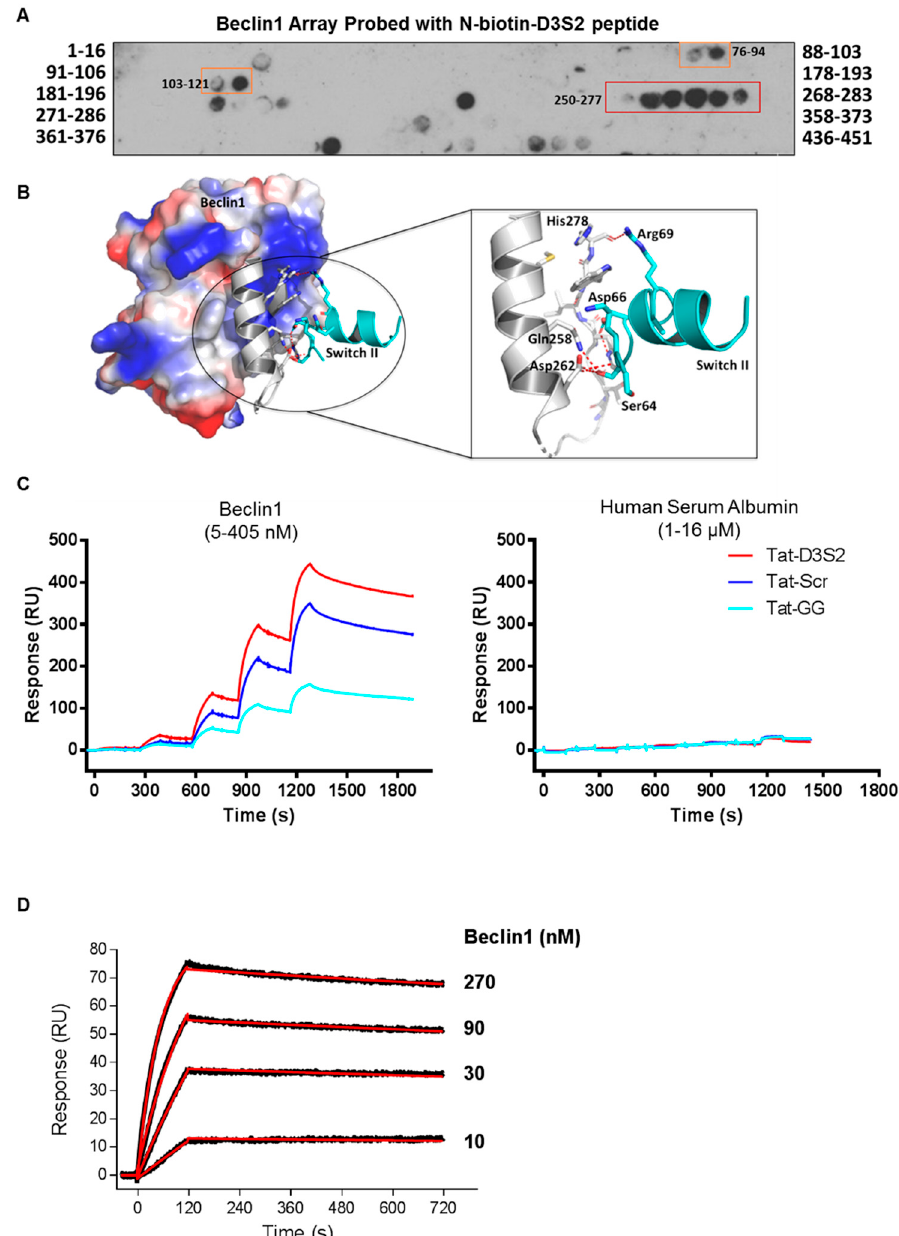
Figure 4. DIRAS3 switch II-derived peptide interacts with Beclin1. ( A ) N-biotin-D3S2 peptide overlay of a peptide array comprising residues 1 − 450 of Beclin1. A 16mer peptide array staggering every other residue was probed with the DIRAS3 switch II-derived peptide. Interaction between the peptide and amino acids 250 − 277 (red box) of Beclin1 was revealed. ( B ) FlexPepDock server was used for docking the modeled peptide to Beclin1 crystal structure (PDB ID:4DDP). Beclin1 is depicted in electrostatic surface, while the probable peptide binding region of Beclin1 and docked peptide are shown in grey and cyan colors, respectively. ( C ) Surface plasmon resonance (SPR) was used to determine the binding specificity of the DIRAS3 switch II-derived peptides with Beclin1. SPR was performed with Tat-GG (~150 RU), Tat-Scr (~280 RU) or Tat-D3S2 (~280 RU) peptides immobilized in CM3 sensor chip (GE). Recombinant Beclin1 (5, 15, 45, 135 and 405 nM) or human serum albumin (1, 2, 4, 8 and 16 µ M) protein were titrated sequentially onto the peptide sensor and the sensograms obtained. ( D ) To determine the binding a ffi nity of the DIRAS3-derived switch II peptide (D3S2) to Beclin1, c-terminal biotinylated D3S2 peptide (~120 RU) was immobilized and Beclin1 recombinant protein was injected at the concentrations as indicated. The sensograms (shown in black) were obtained and the association rate ( k a ), dissociation rate ( k d ) and equilibrium dissociation ( K D ) constants were determined from fitting (shown in red).